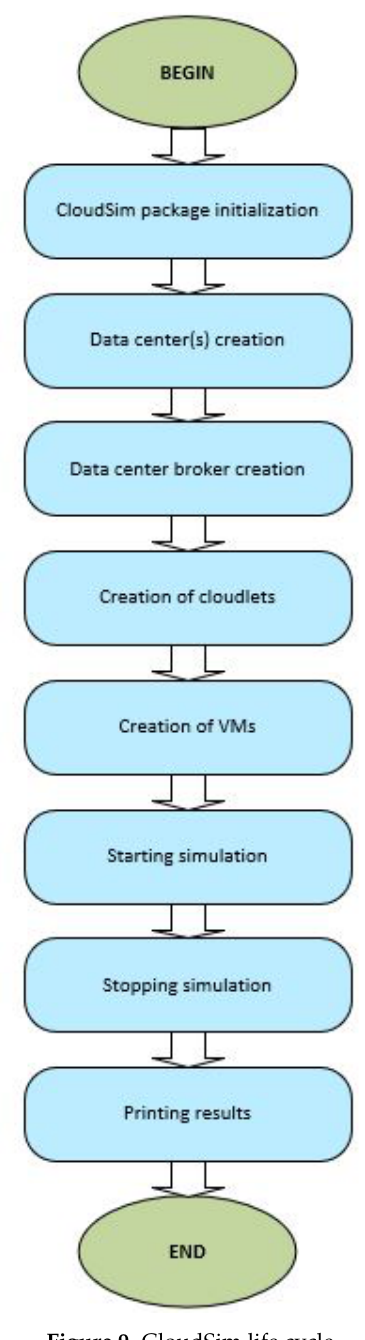
Figure 9. CloudSim life